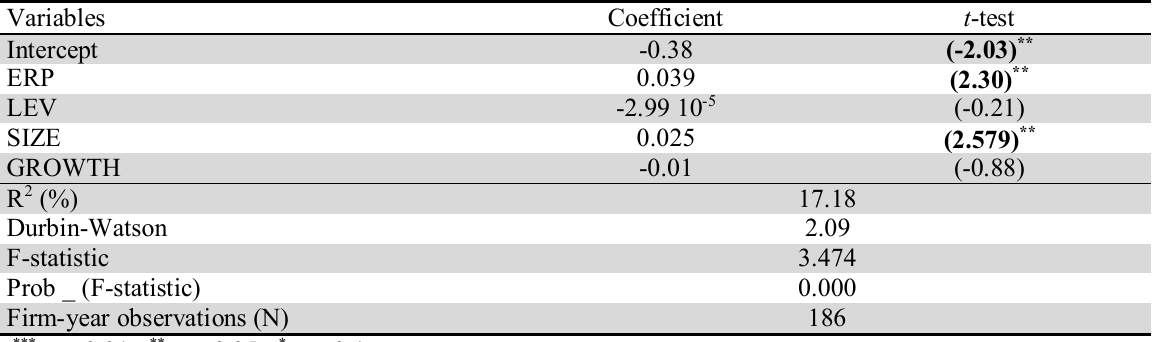
GLS regression model (Eq. (A.1)) with ROA